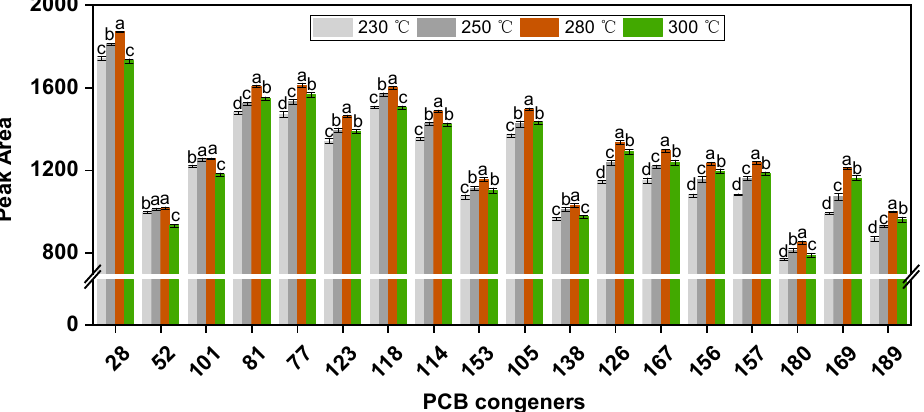
Figure 2. Effect of ion source temperature on the response intensity of the target PCBs. Different lowercase letters indicate significant differences at p < 0.05 under different treatments.